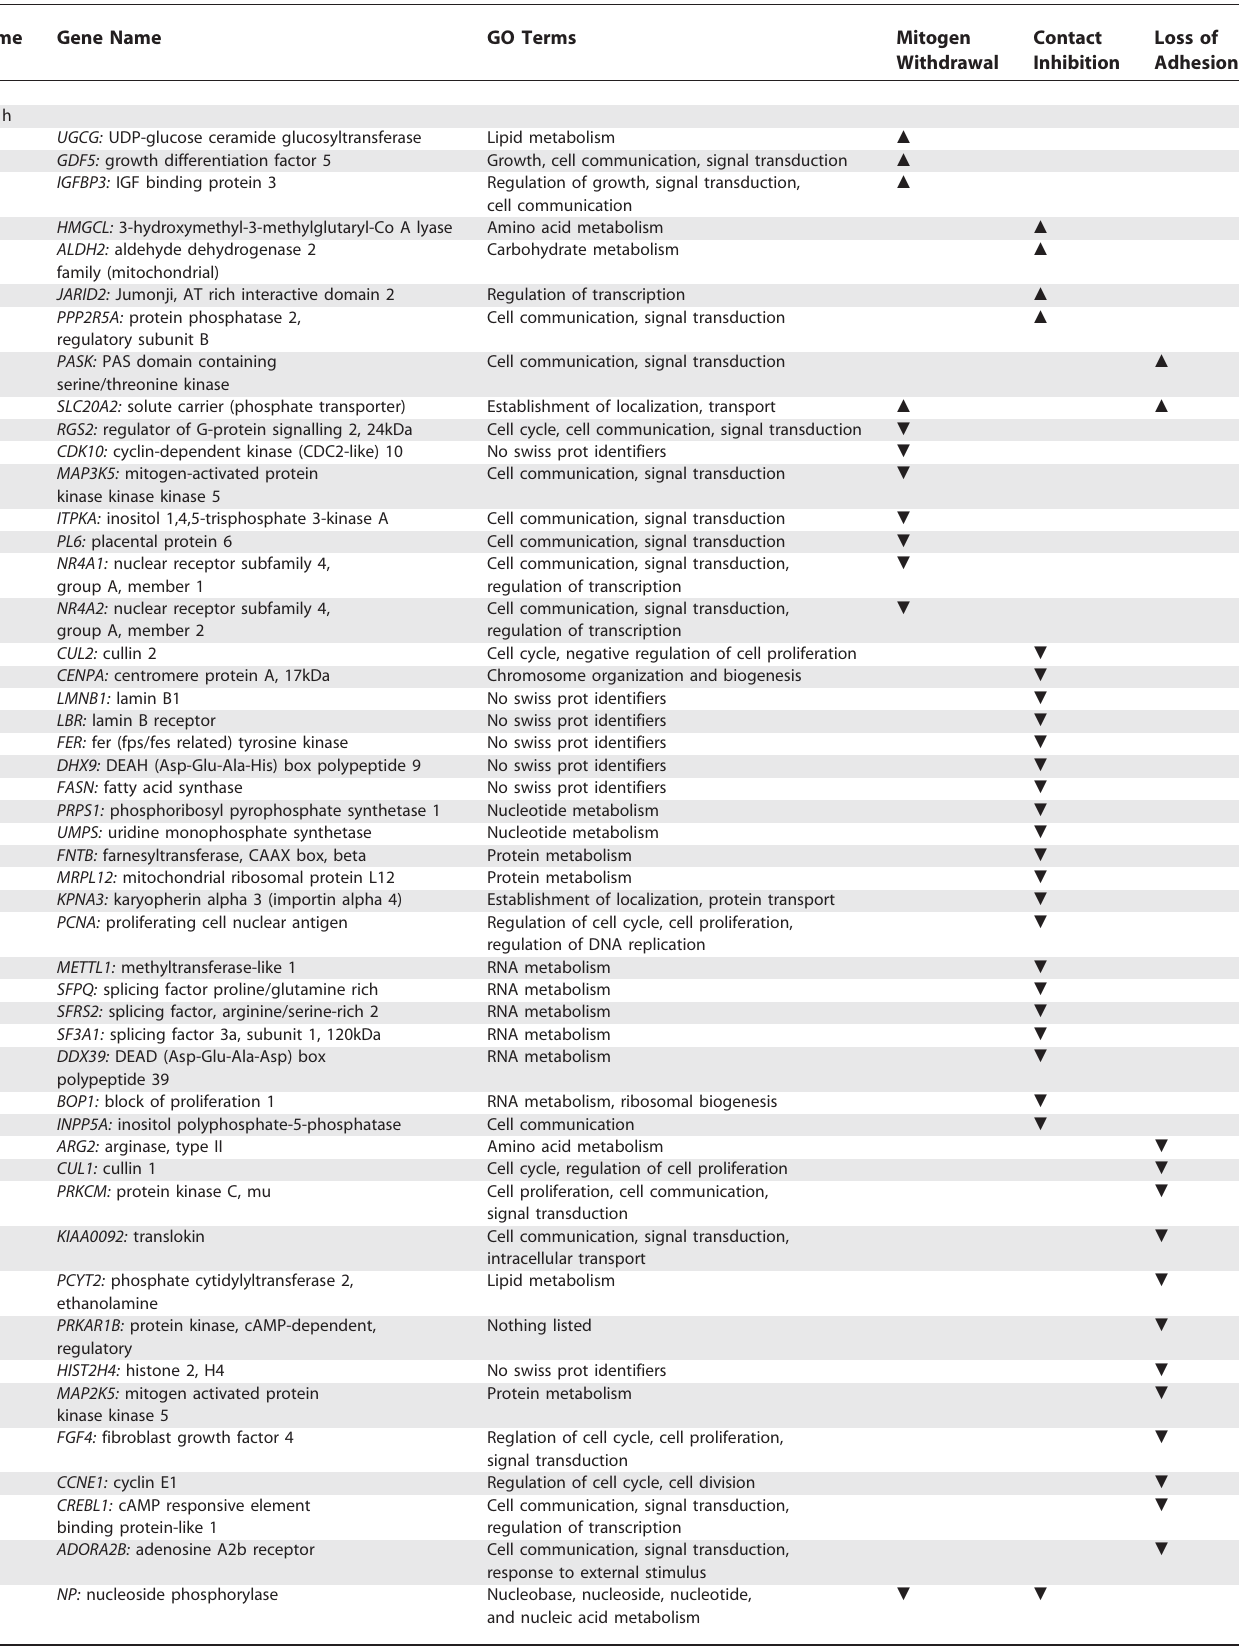
Table 1. Genes Regulated by Specific Arrest